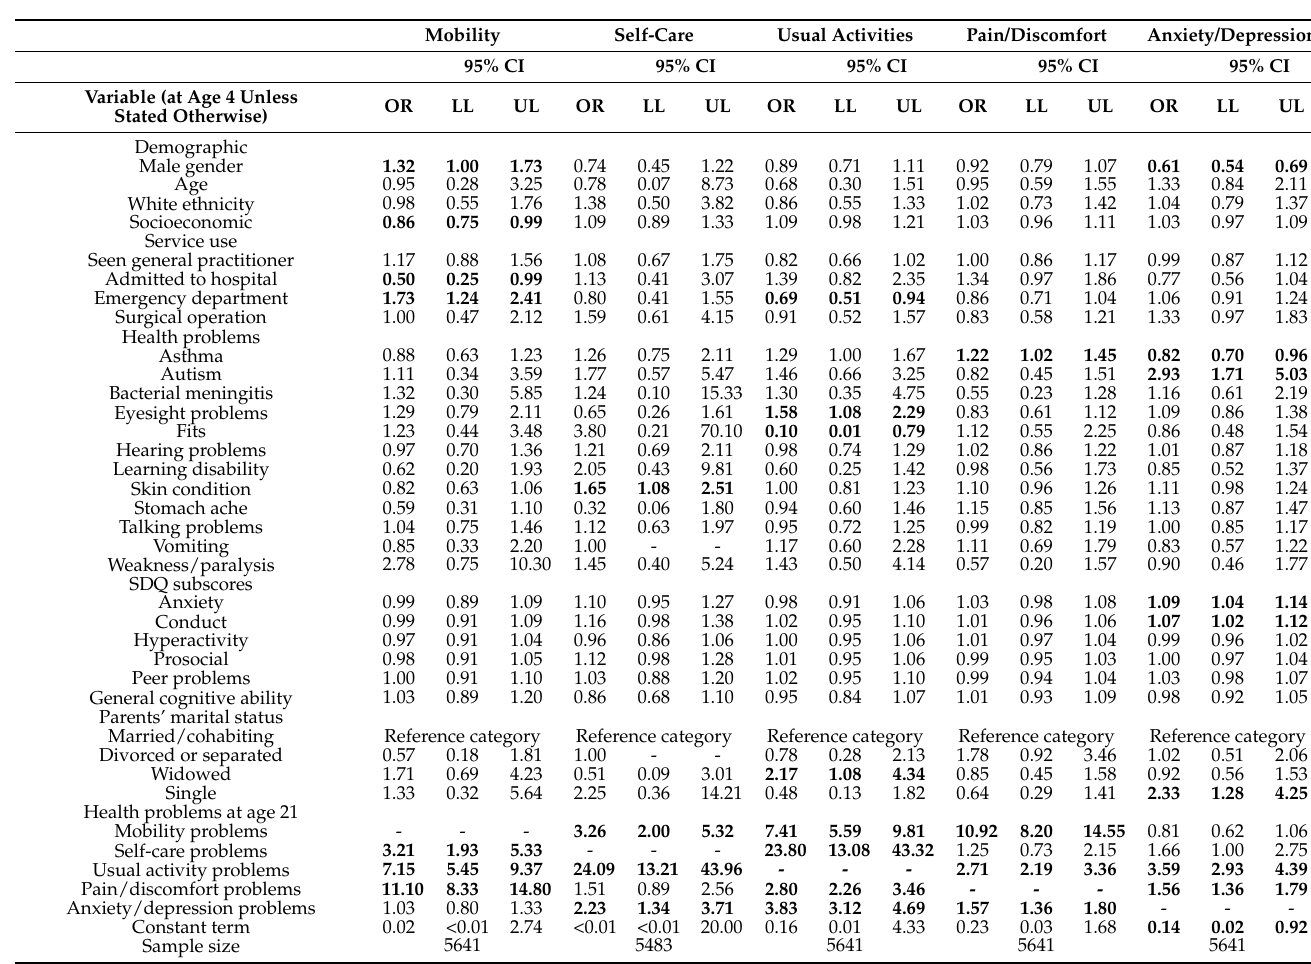
Table 5. Generalised estimating equations showing predictors of problems on EQ-5D-5L domains at age 21. Mobility Self-Care Usual Activities Pain/Discomfort